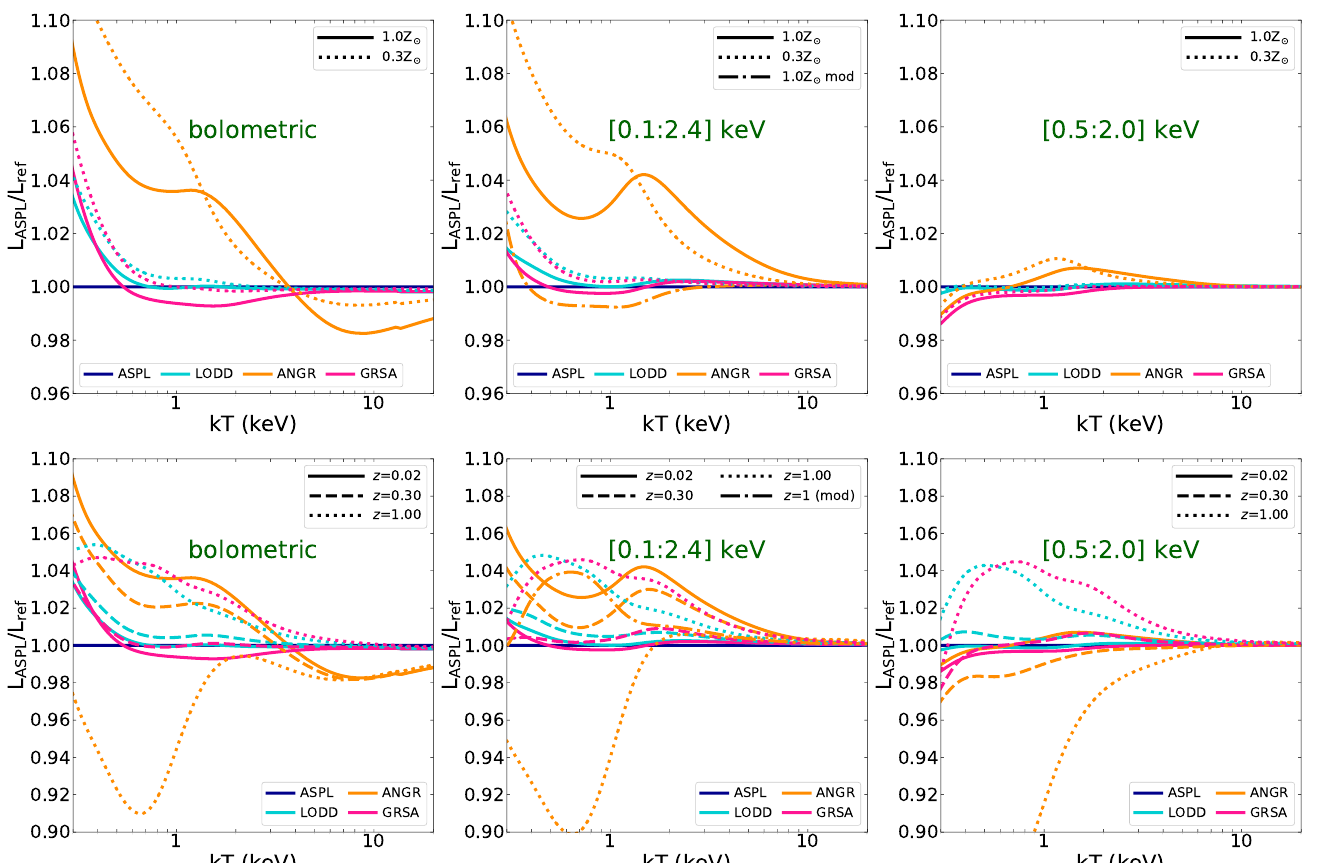
Figure 2. Ratio between the rest-frame L x ( left panels : bolometric, middle panels : 0.1–2.4 keV band, right pan- els : 0.5–2 keV band) derived using the abundances as in Asplund et al. [71] and L x obtained with the abundances of (Grevesse and Sauval [84], pink), (Lodders et al. [85], turquoise), and (Anders and Grevesse [86], orange), respectively. In the top panels we show the results for systems at z = 0.02 with a metallicity of 1.0 (solid lines) or 0.3 times the solar abundance. The dashdot line in the middle panels refers to the simulations with a modified table of ANGR in which the Fe abundance was set equal to the value of ASPL, showing that indeed most of the differences arise from the significant discrepancy in Fe between ANGR and the other tables. The 0.5–2 keV band (i.e., the band used to rescale the APEC normalization) provide the best agreement between the different tables. In the bottom panels , we show the impact on L x of changing abundance table for systems at different redshifts: z = 0.02 (solid line), z = 0.3 (dashed), and z = 1 (dotted, dashdotted). The simulations were performed with Z = 1Z (cid:12) . The plot shows how the differences increases with z , although the effect is generally smaller than ∼ 5% unless very high z are considered. The residual difference between ASPL and the modified ANGR table for high z objects is due to the differences in elements other than Fe (e.g., C, N, O, Ne, Mg, Si,